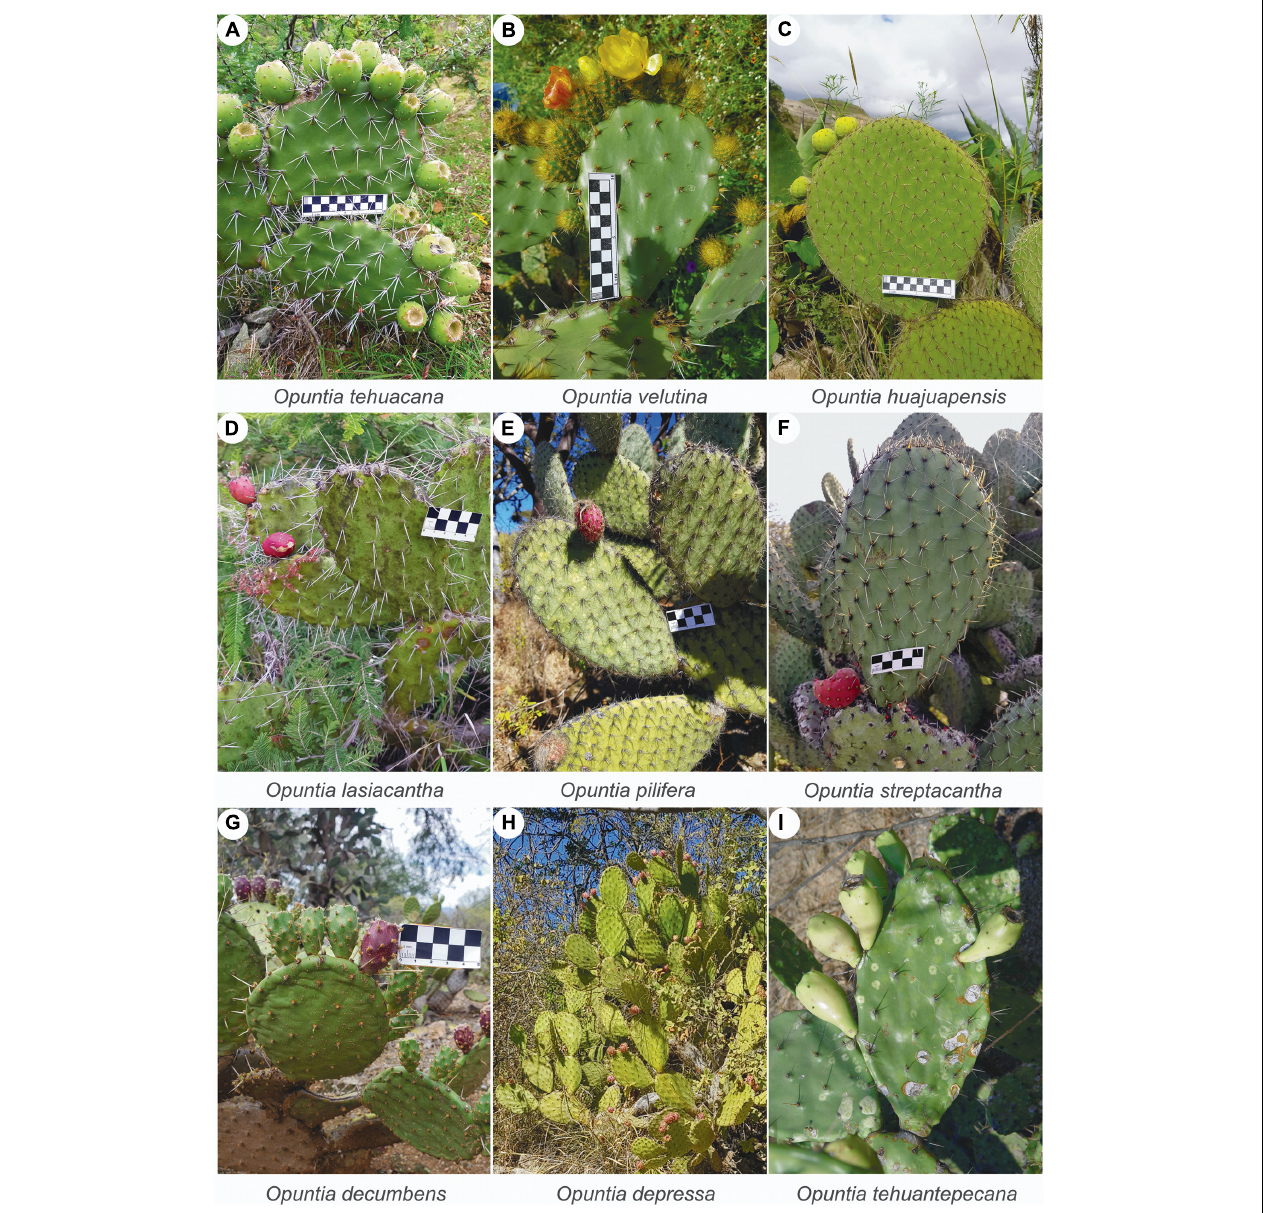
FIGURE 1 | (A–I) Images of the nine Opuntia species analyzed on this work. (C,E) Species O. huajuapensis and O. pilifera putative parentals of O. tehuacana , as proposed by Arias et al. (2012). Photos by X. Granados and S.